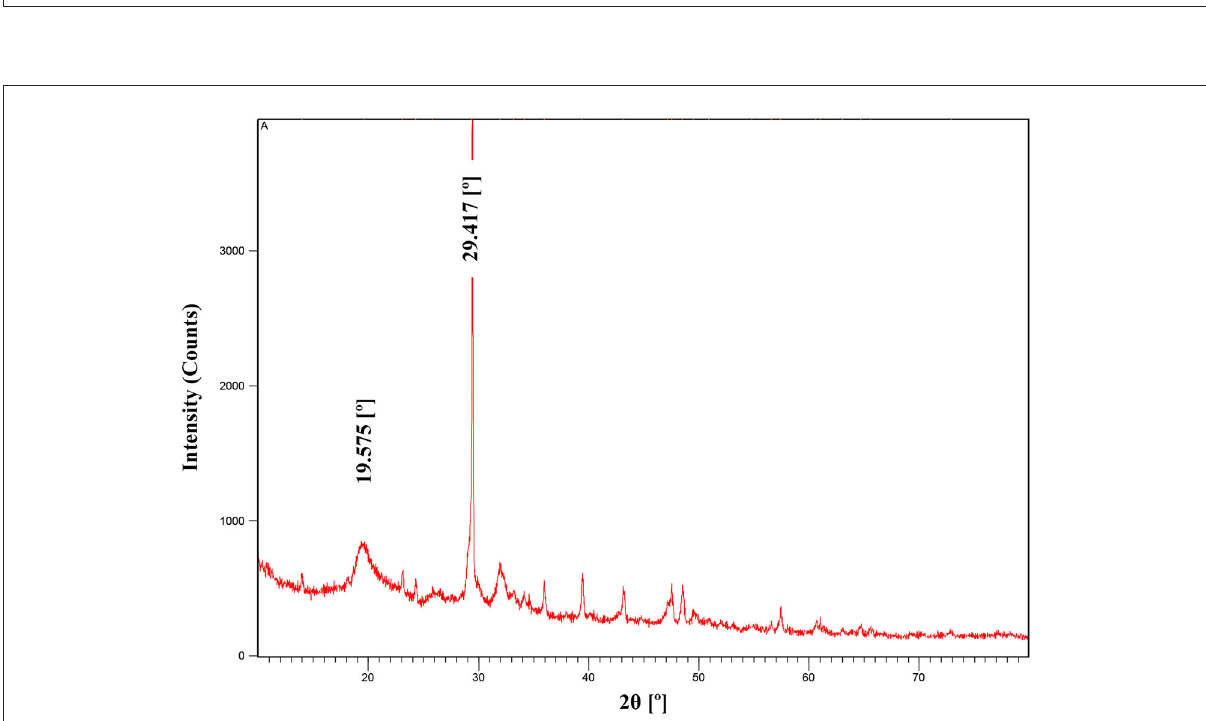
FIGURE2 X-ray diffraction (XRD) pattern of extracted